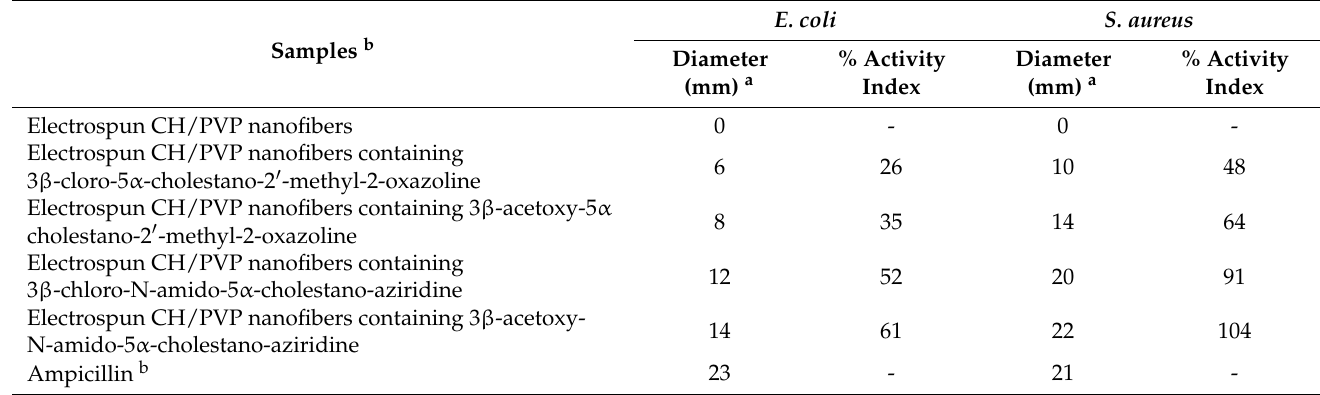
Table 5. Antimicrobial properties of the electrospun CH/PVP nanofibers.